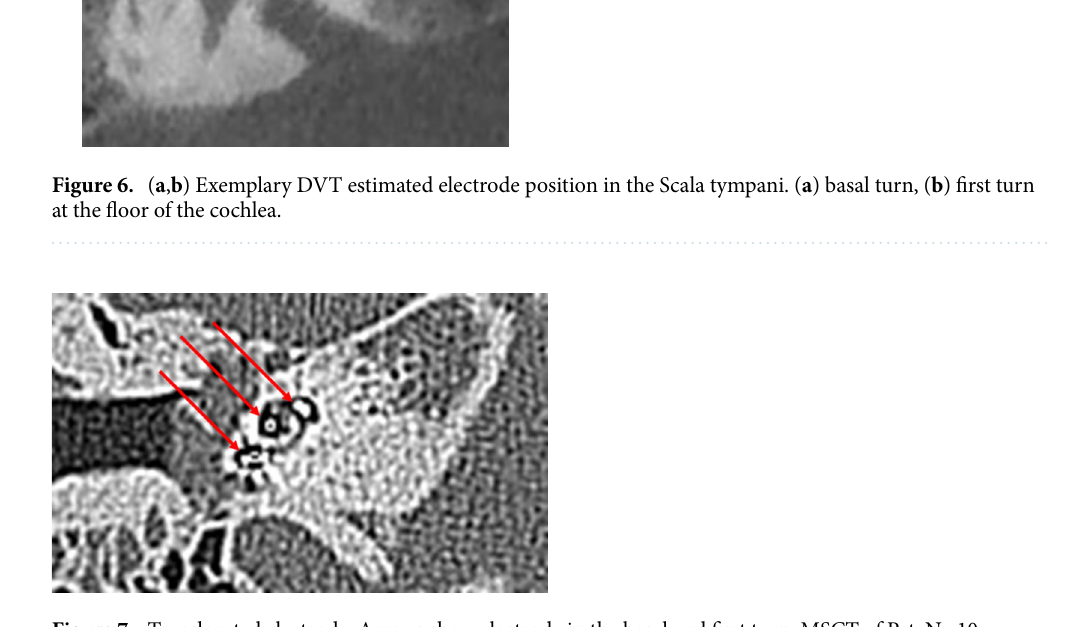
Figure 7. Translocated electrode. Arrows show electrode in the basal and first turn. MSCT of Pat.